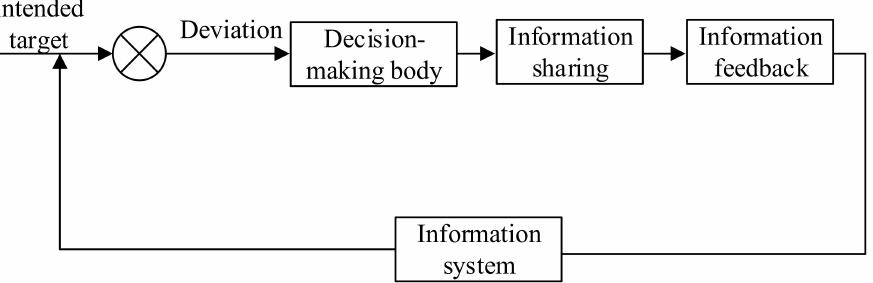
Figure 5. Information sharing and feedback